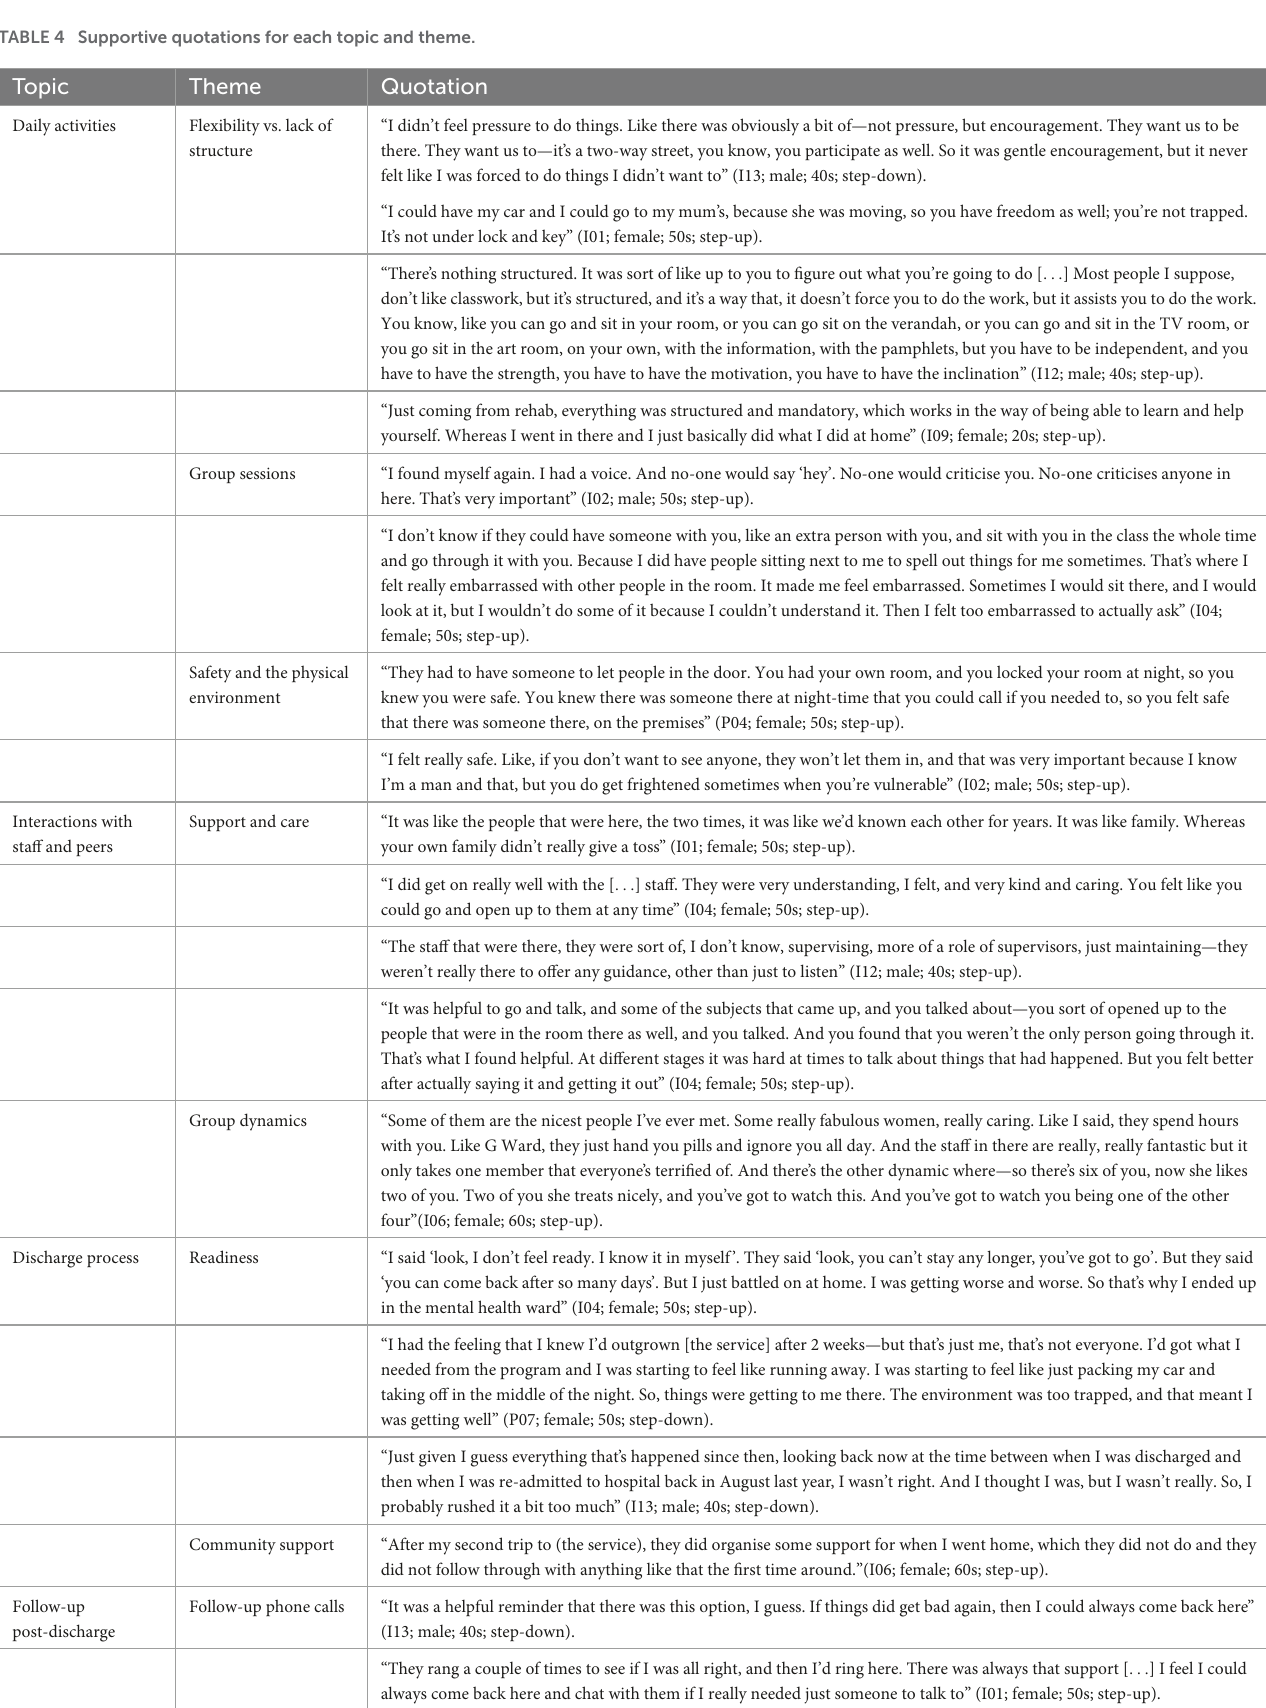
TABLE 4 Supportive quotations for each topic and theme. Topic Theme Quotation Daily